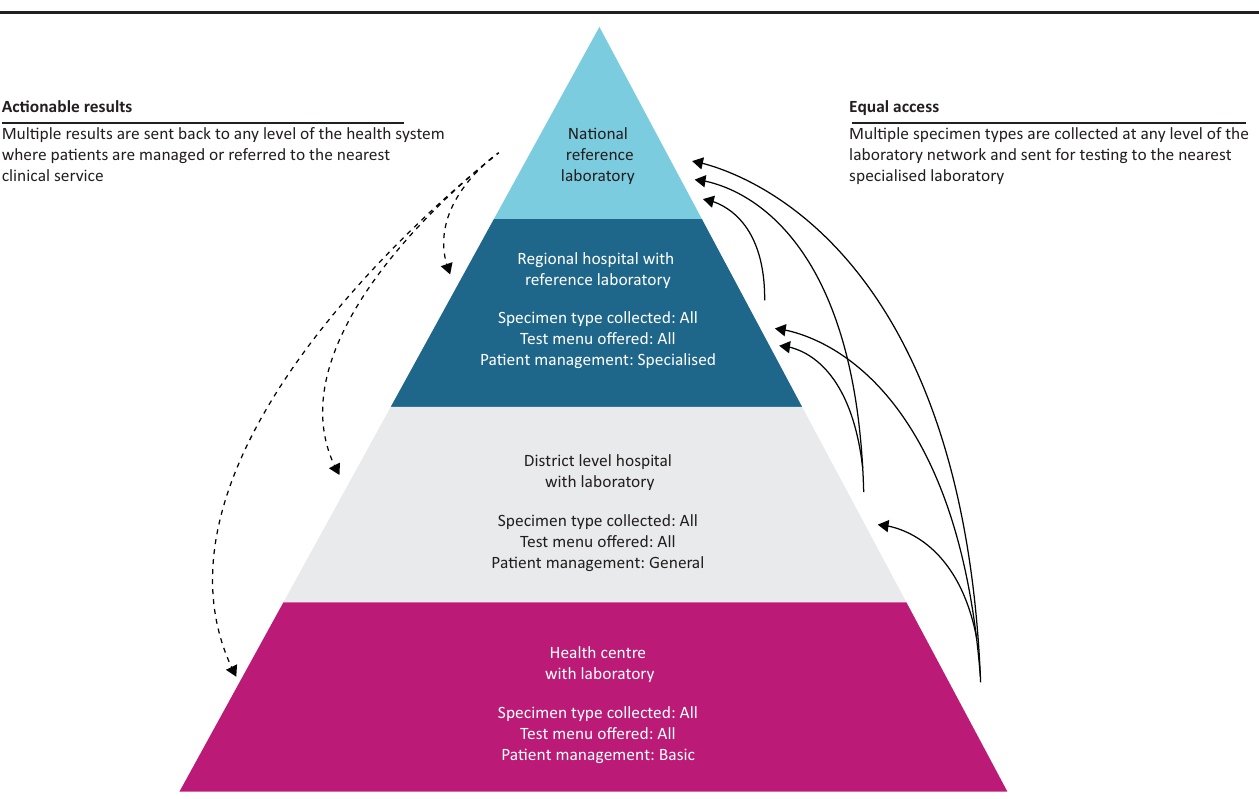
FIGURE 1: Vertical and horizontal integration of diagnostic services across the laboratory network allows all patients to access the same testing menu regardless of their entry point to the health